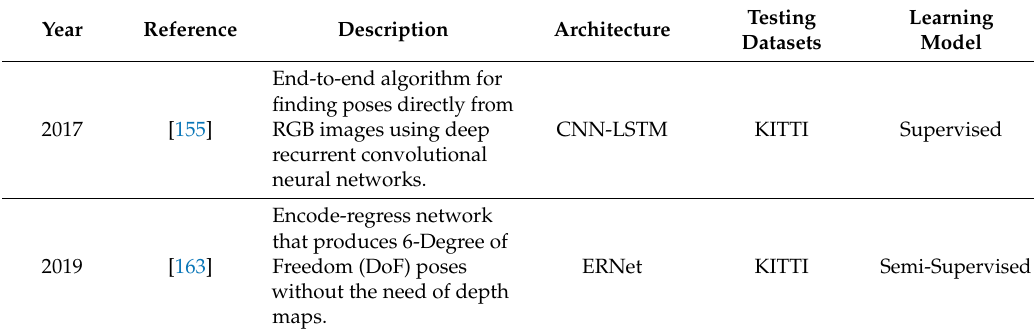
Table 9. Recent VO algorithms based on deep learning